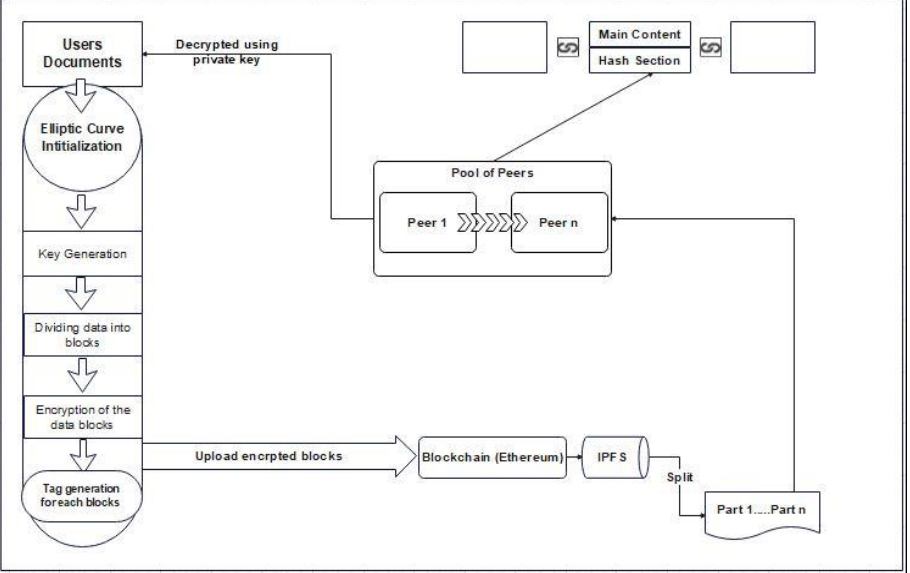
Figure 5. EVM-ECC Architecture.